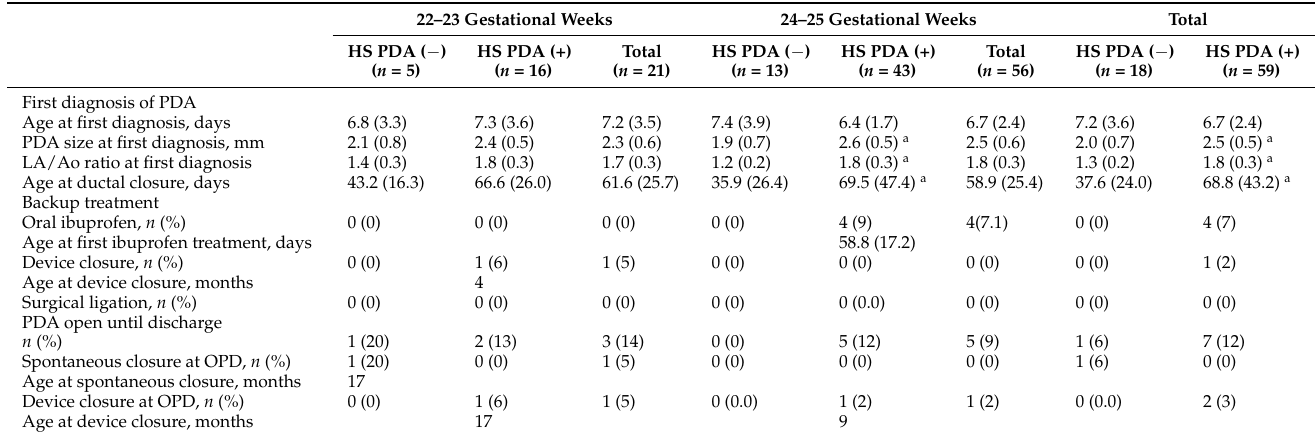
Table 1. PDA-associated variables and outcomes of the infants with or without HS PDA according to gestational weeks.